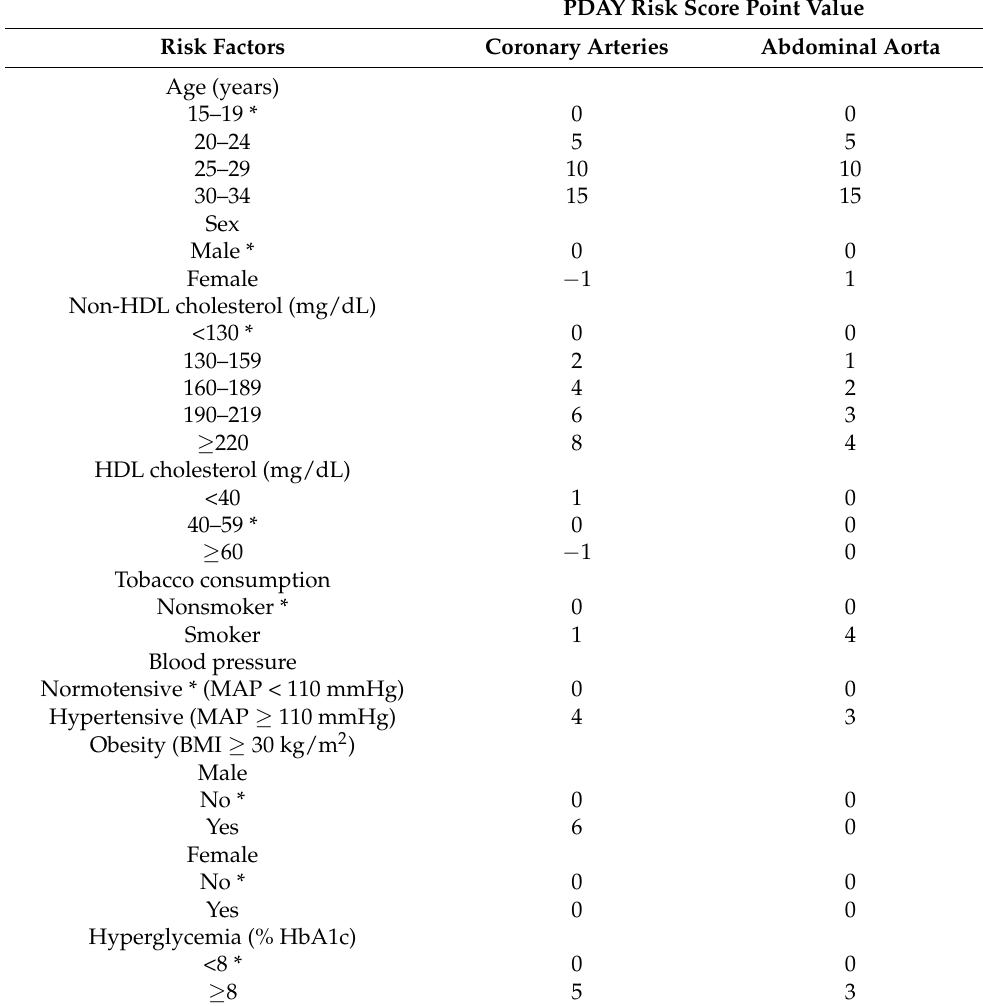
Table 4. Pathobiological Determinants for Atherosclerosis in Youth (PDAY) risk score, predicting target lesions in the coronary arteries and the abdominal